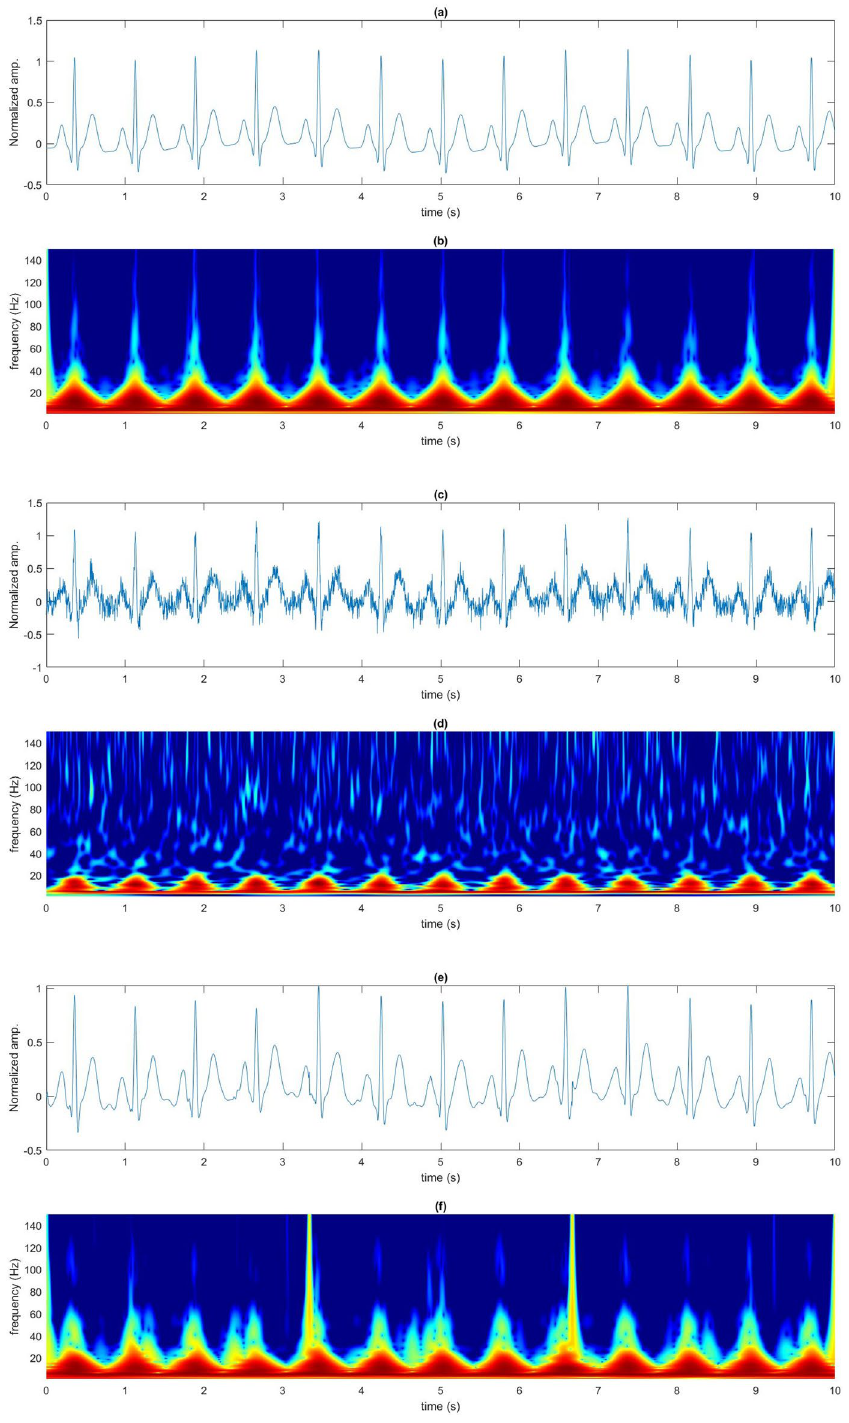
Figure 1. Time-frequecy domain for CEEMDAN-WD denoising ( a ) Waveform of original artificial ECG signal, ( b ) Spectrogram of original artificial ECG, ( c ) Waveform of artificial ECG signal with 2 dB of white Gaussian noise, ( d ) Spectrogram of artificial ECG signal with 2 dB of white Gaussian noise, ( e ) Waveform of partially reconstructed denoised ECG signal by CEEMDAN-WD proposed method, ( f ) Waveform of partially reconstructed denoised ECG signal by CEEMDAN-WD proposed